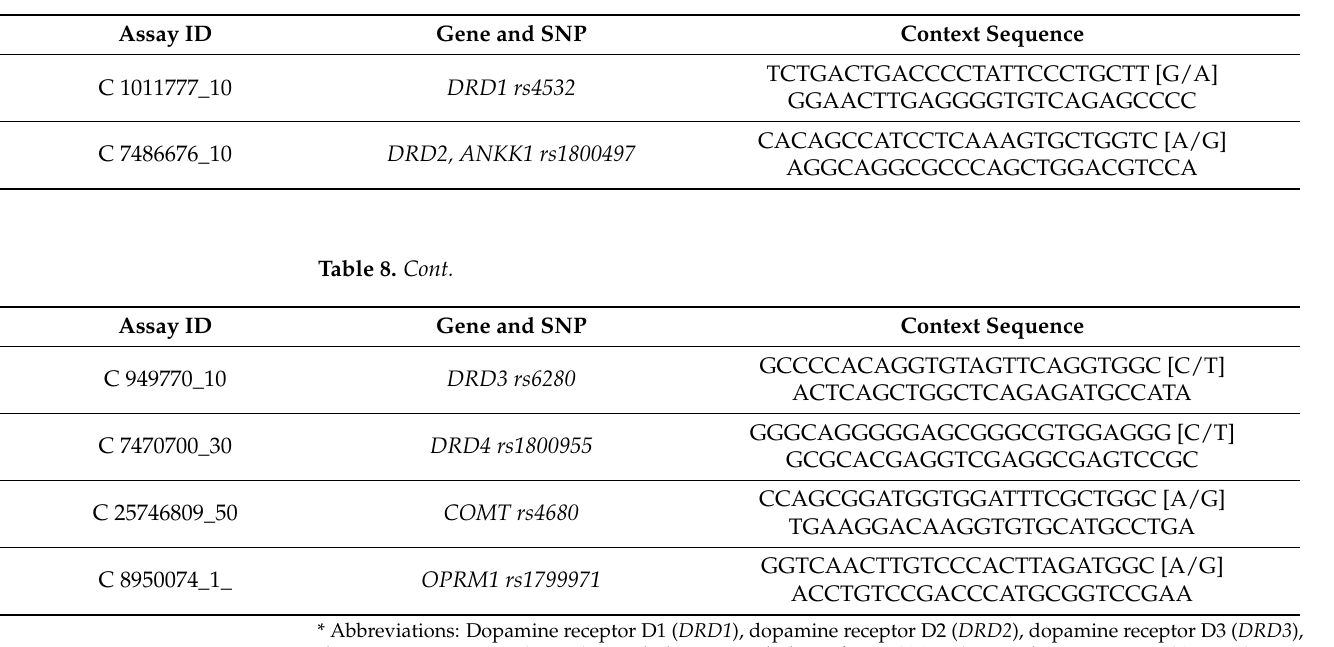
Table 8. GARS single nucleotide polymorphism assay information—TaqMan *.